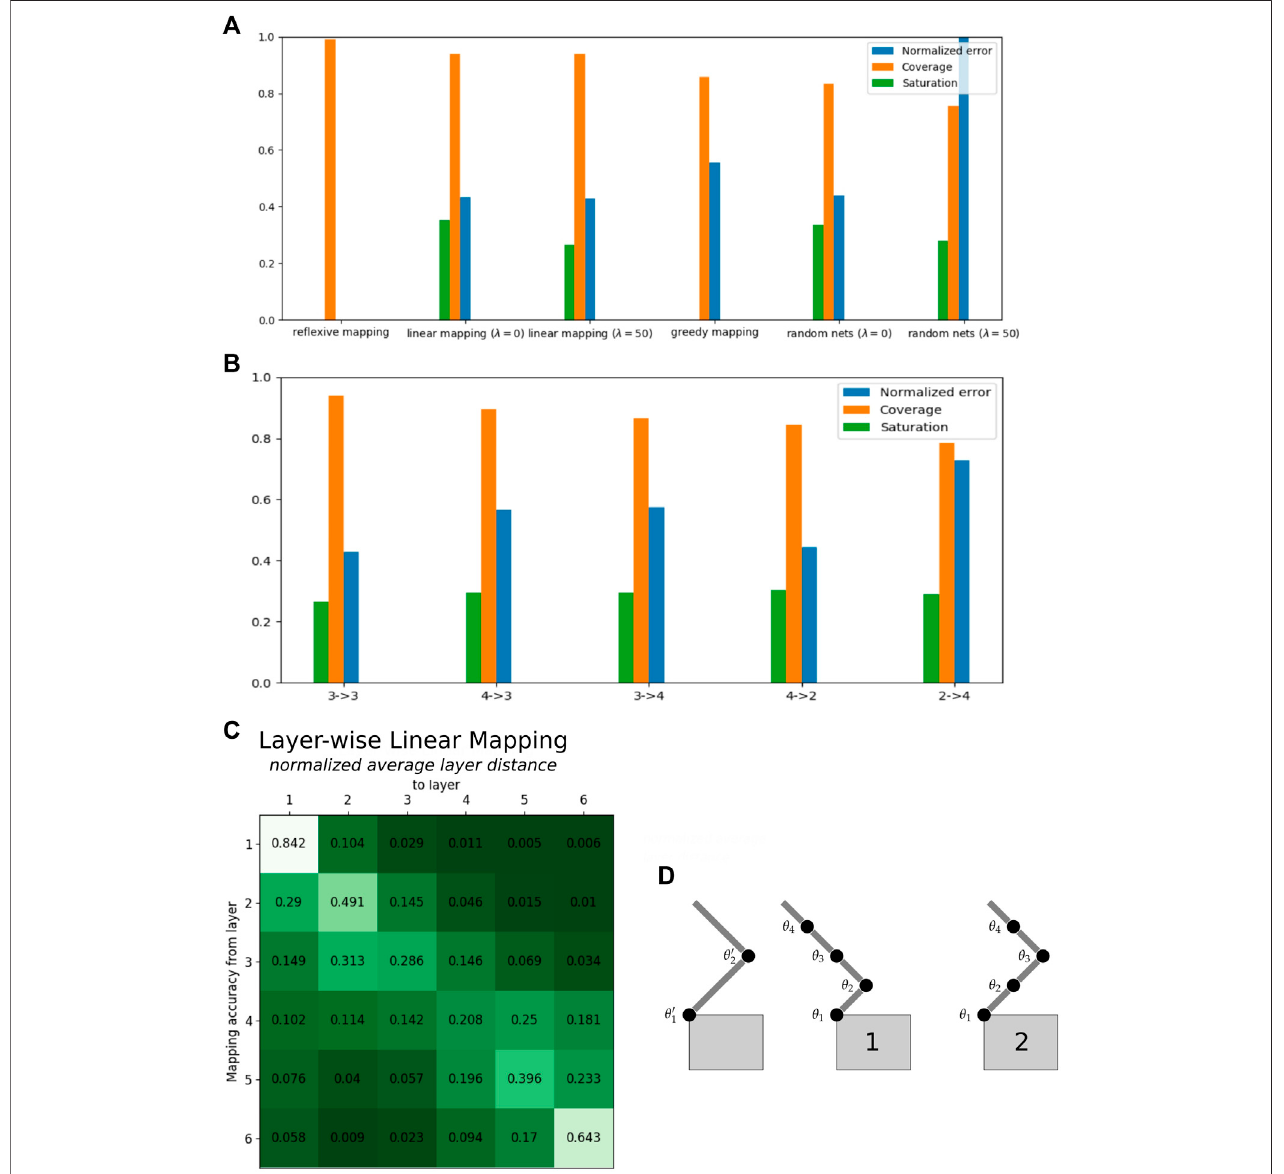
FIGURE6| Projectionofneuronactivationbetweennetworkstrainedforvariablejointrobotmanipulators(dataaveragedwith fi venetworkseachandthreepruning steps). (A) Benchmarkofmappingtechniqueandevaluationmetrics:ontheexampleofmultiplethree-jointmanipulatornetworks,we fi ndlinearmappingwith λ =50,the superior mapping approach in contrast to greedy mapping. In particular, coverage and normalized errors indicate mapping quality well in comparison to untrained networks. (B) Neuronactivationcorrelationsofnetworkstrainedonrobotswithdifferentjointcount(2 – 4referstoamappingfromnetworkstrainedforatwo-jointto a four-joint robotic arm): the mapping error gets higher with increased difference in joint numbers, and the coverage accordingly decreases. Mapping a network with higher complexity into lower complex ones performs slightly better than vice versa. In this study, the mappings 4-2 are closest to the performance of the native 3-3 mappings. This mapping isin fl uenced by aproper transformation of sensory inputs to the increased number of input neurons on the fi rst layer (bottom right). The results aredemonstratedforbalancedmappingin (D2) as θ 1 ′ = θ 1 , θ 2 ′ = θ 3 , θ 2 =0, θ 4 =0whichoutperformthenaivemapping θ 1 ′ = θ 1 , θ 2 ′ = θ 2 , θ 3 =0, θ 4 =0depictedin (D1) .All results are the mean of 25 mappings. (C) A layer-wise linear mapping with λ = 50 is not optimal, but strongest correlations can be found between corresponding layers. This is represented in the higher diagonal values in the table of normalized average layer distances on bottom left. Here, layers 1 and 6 show best mapping (initialization with six layers each 256 neurons before pruning and random nets with average pruned network size of s = [46 22 16 13 8 20] neurons per layer).